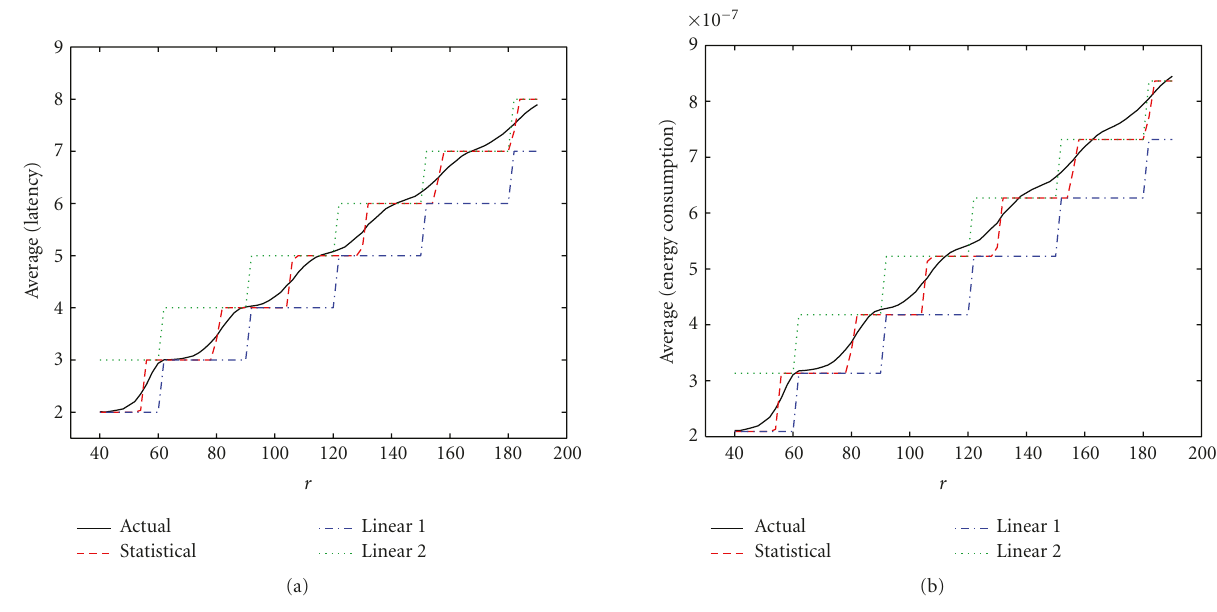
Figure 5: Estimation average: (a) latency; (b) energy